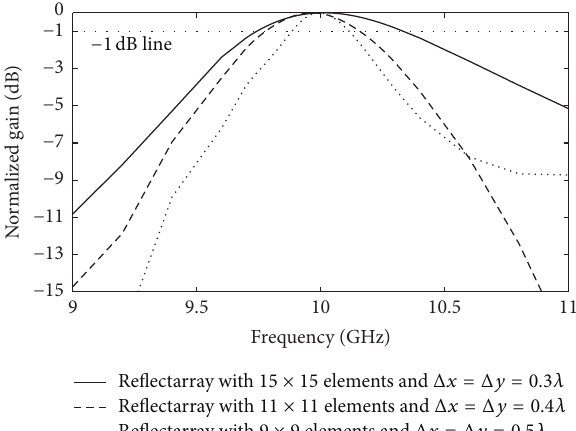
Reflectarray with 9 × 9 elements and Δx = Δy = 0.5𝜆 Figure 25: Comparison between computed gain patterns versus frequency of differently spaced reflectarrays.